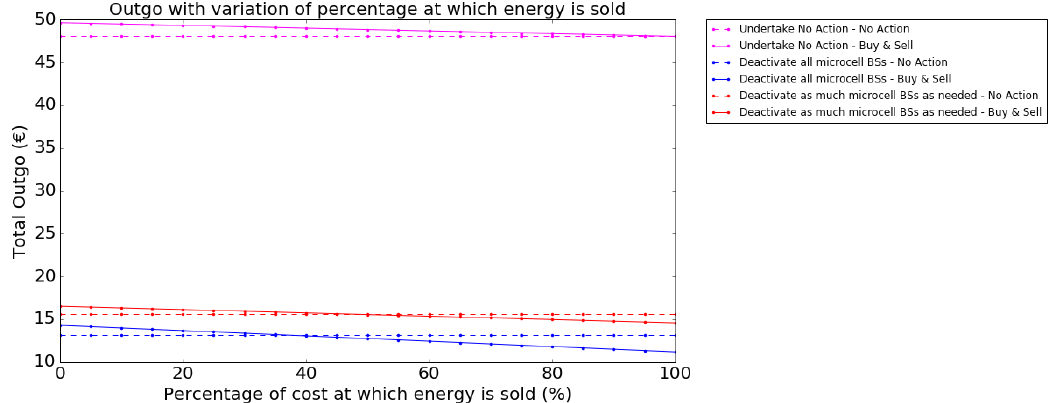
Figure 12. Buy and sell: percentage of energy market price at which energy is sold to the power